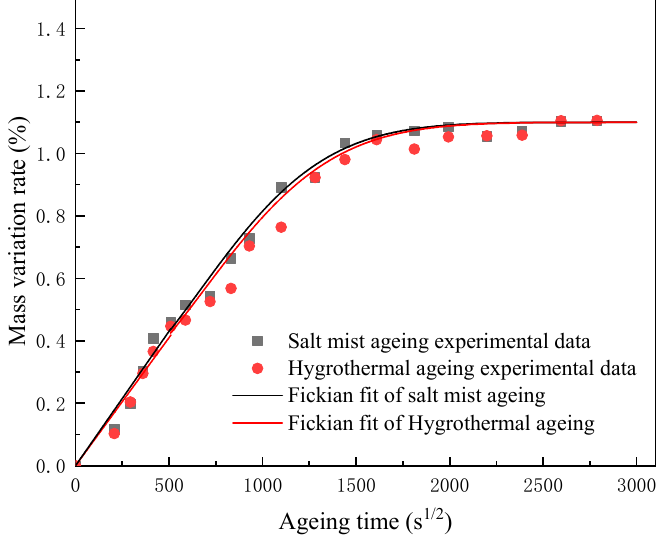
Figure 4. Fickian fit.